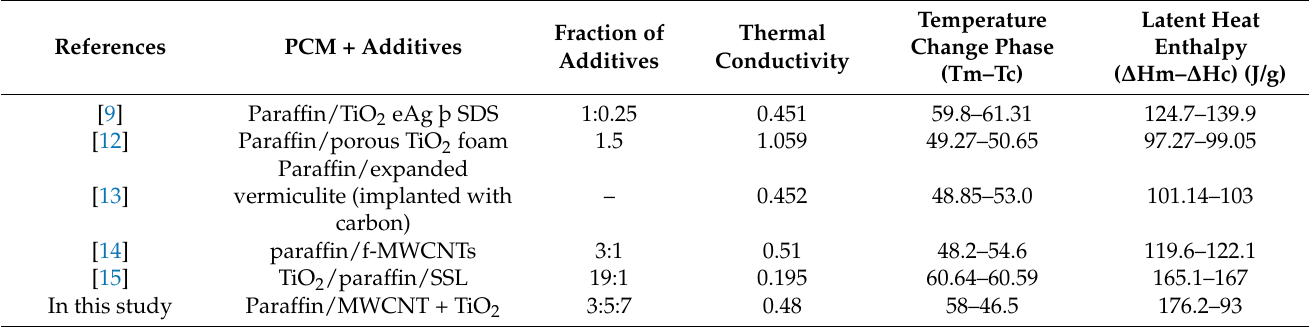
Table 1. Comparison of the latent heat of the composite PCMs prepared in this study with some reported PCMs for thermal energy storage